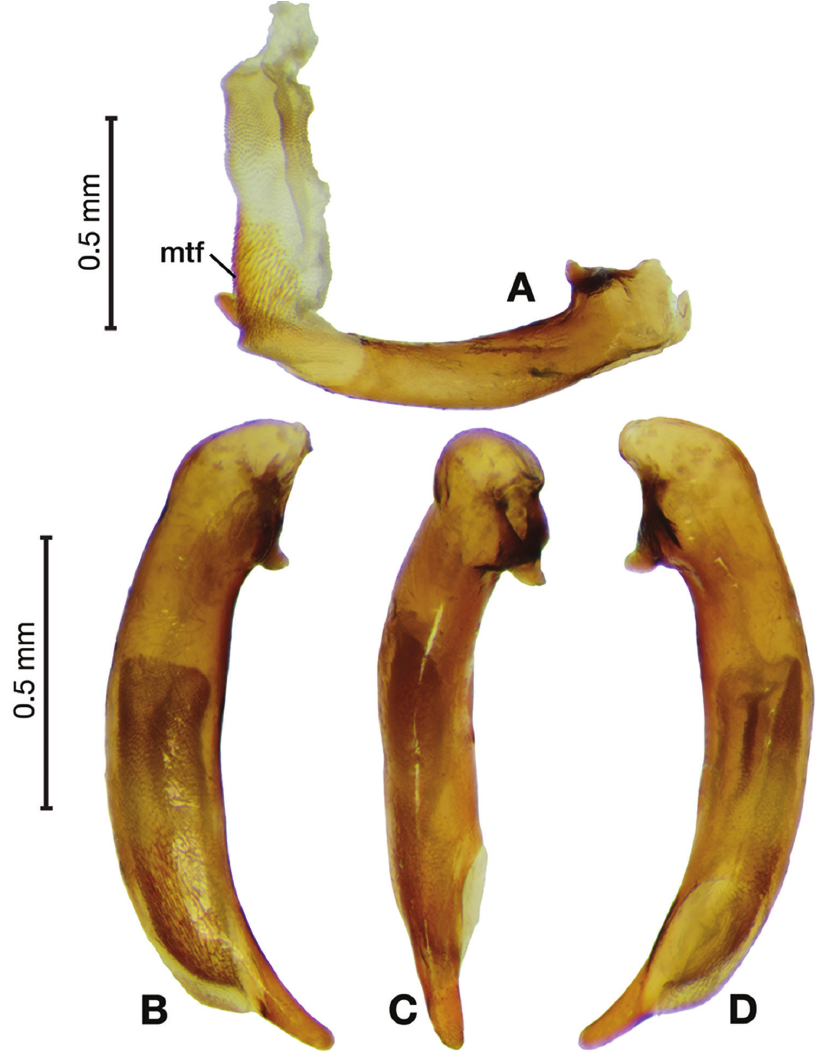
Figure 99. Digital images of male genitalia of Mochtherus obscurabasis sp. n.. A left lateral aspect, endophal- lus everted B right lateral aspect C ventral aspect D left lateral aspect. Legend: mtf microtrichial